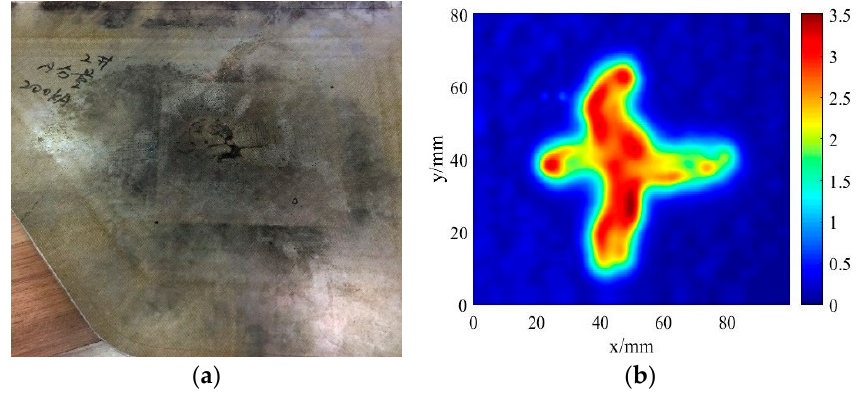
Figure 12. 200 kA current test. ( a ) Impacted specimen, ( b ) Eddy current testing.